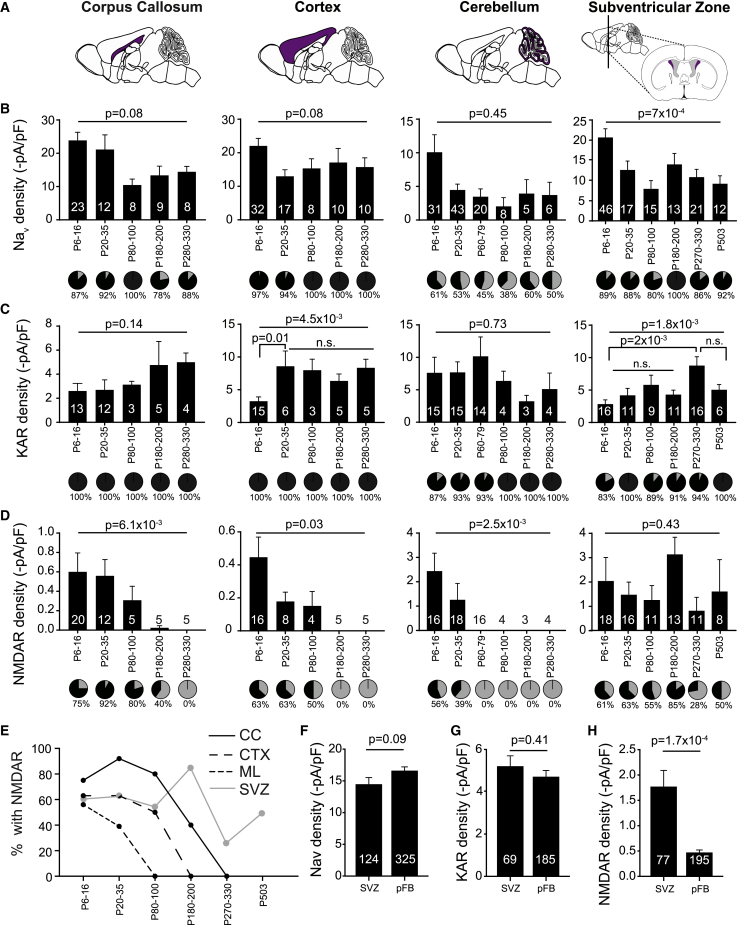
Ion Channel Densities in OPCs Change Differently across the Lifespan in the CC, CTX, Cerebellum, and Subventricular Zone(A) Illustration of the brain areas (purple) where OPCs were whole-cell patch-clamped: CC, a highly myelinated region; CTX, a lightly myelinated region; cerebellar molecular layer (ML), a region that is never myelinated in mice; and subventricular zone (SVZ), an area that provides a continuous supply of myelinogenic OPCs throughout life.(B) NaV densities (bar graph) did not change across postnatal age in the CC (left), CTX (center left), or ML (center right) but did change in the SVZ (right). The proportion of OPCs with detectable NaV (black) changed throughout postnatal life in the CC (p = 3.1 × 10−5, χ2), the CTX (p = 2.6 × 10−3, χ2), and the ML (p = 6.5 × 10−3, χ2), but not the SVZ (p = 0.7, χ2).(C) AMPA/KAR densities increased with age in the CTX and the SVZ but remained stable in other areas throughout life. Throughout postnatal life, KA (30 μM) evoked currents in all OPCs except in the ML, where, in the first 3 months of life, a small proportion of OPCs had no detectable KA-evoked currents, and in the SVZ, where OPCs with no KA-evoked response could be found throughout life. The proportion of OPCs with kainite-evoked currents only changed with age in the hindbrain (CC, p = 1, χ2; CTX, p = 1, χ2; ML, p = 2.5 × 10−6, χ2; SVZ, p = 0.61, χ2).(D) NMDAR densities significantly declined in all areas except the SVZ across postnatal life, although with a different rate in each area. The proportion of OPCs with detectable NMDA (60 μM)-evoked currents (pie charts) were significantly different across age in all areas except the SVZ, recorded from the following: CC, p < 1 × 10−15, χ2; CTX, p < 1 × 10−15, χ2; ML, p < 1 × 10−15, χ2; SVZ, p = 0.62, χ2.(E) The fraction of postnatal OPCs with detectable NMDA-evoked current in the CC), CTX, ML, and SVZ. NMDARs became undetectable at different times in each region but not in the SVZ (p = 0.003, two-way ANOVA, comparison between areas).(F and G) Neither (F) NaV nor (G) KAR densities differed between parenchymal forebrain OPCs (pFB) and SVZ OPCs.(H) NMDAR density was higher in SVZ OPCs compared with pFB OPCs.Numbers shown on bar graphs represent cell numbers from 1–13 animals. Data are shown ± SEM. Top p values are from ANOVA analyses, and bottom p values are from Holm-Bonferroni post hoc tests.